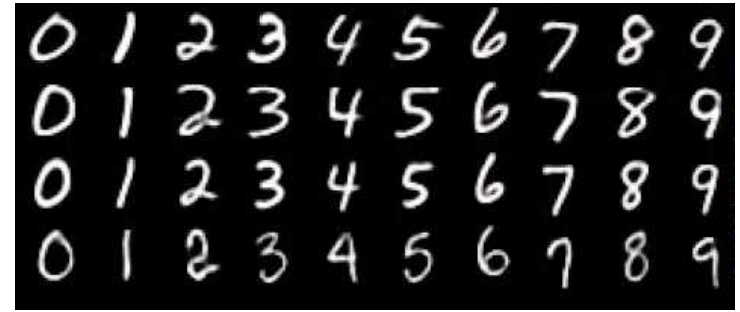
Figure 6. Examples of in-air-written digit number images of the thermo-visually calibrated (TVC)-hand gesture database.